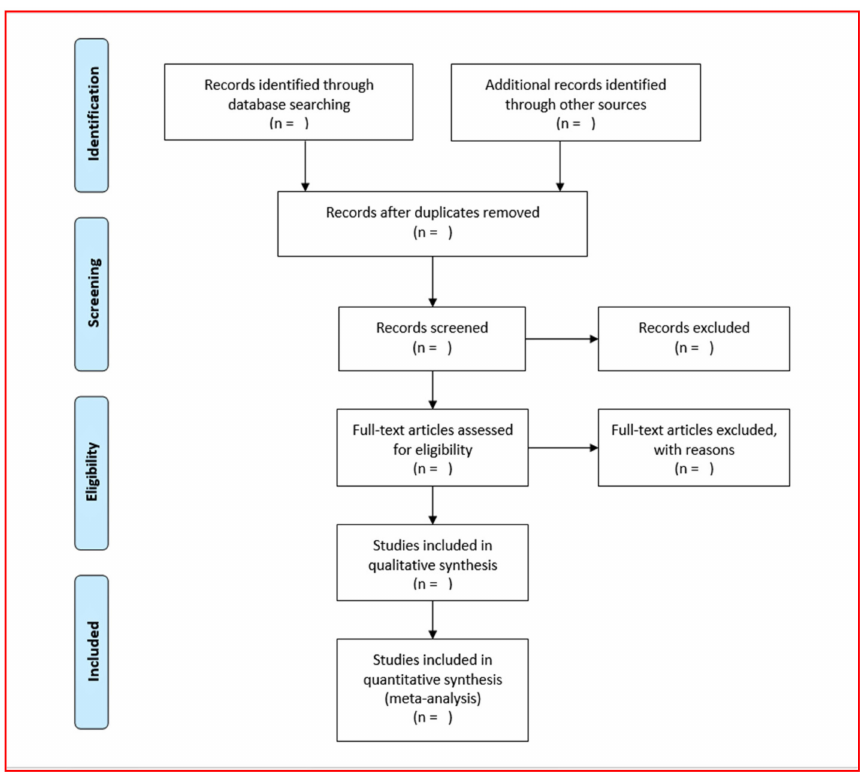
Figure 1. Schematic representation of the selection